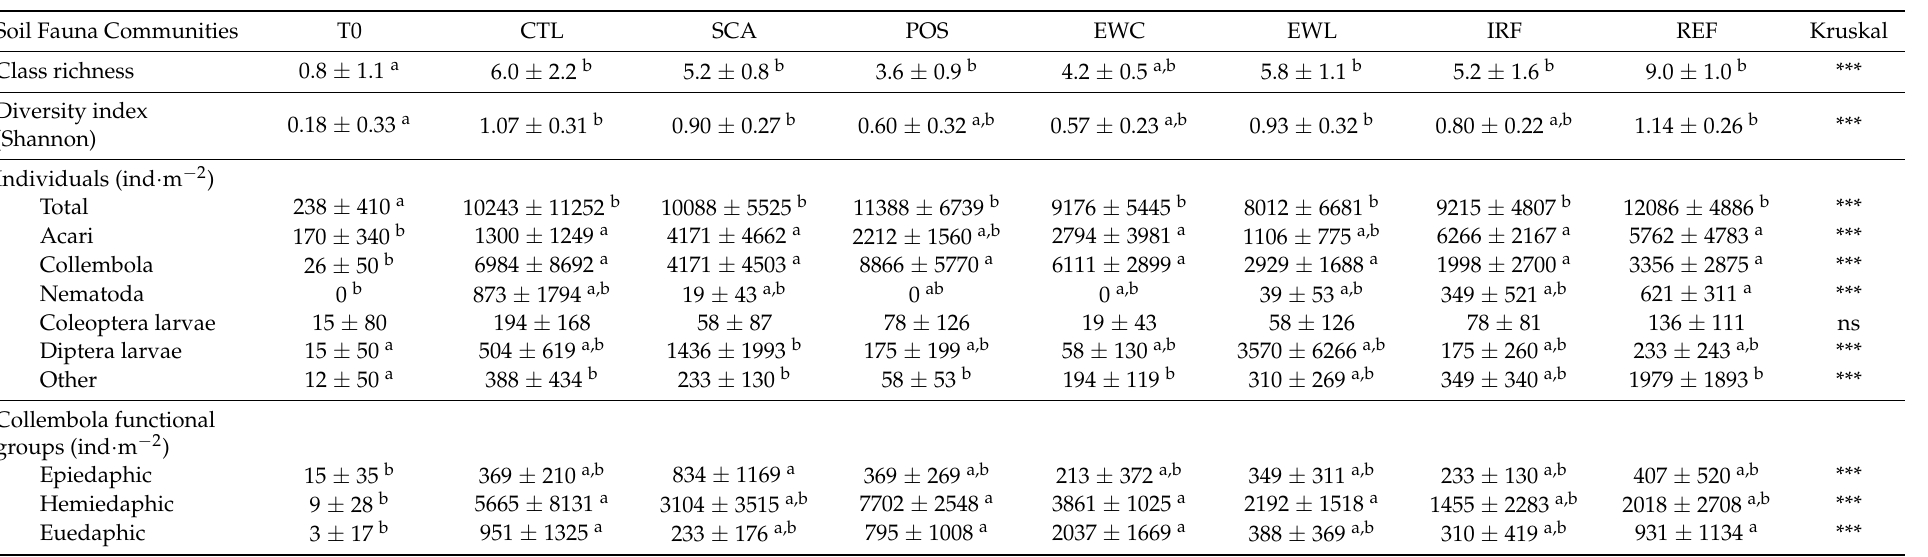
Table 2. Effect of treatment on soil meso- and microfaunal communities (mean ± standard deviation, n = 5 and n = 11 for T0); see the Section 2 for soil restoration technique abbreviations. Statistically valuable difference was assessed using the Kruskal test, *** p ≤ 0.001, ns: no significant difference. Statistical